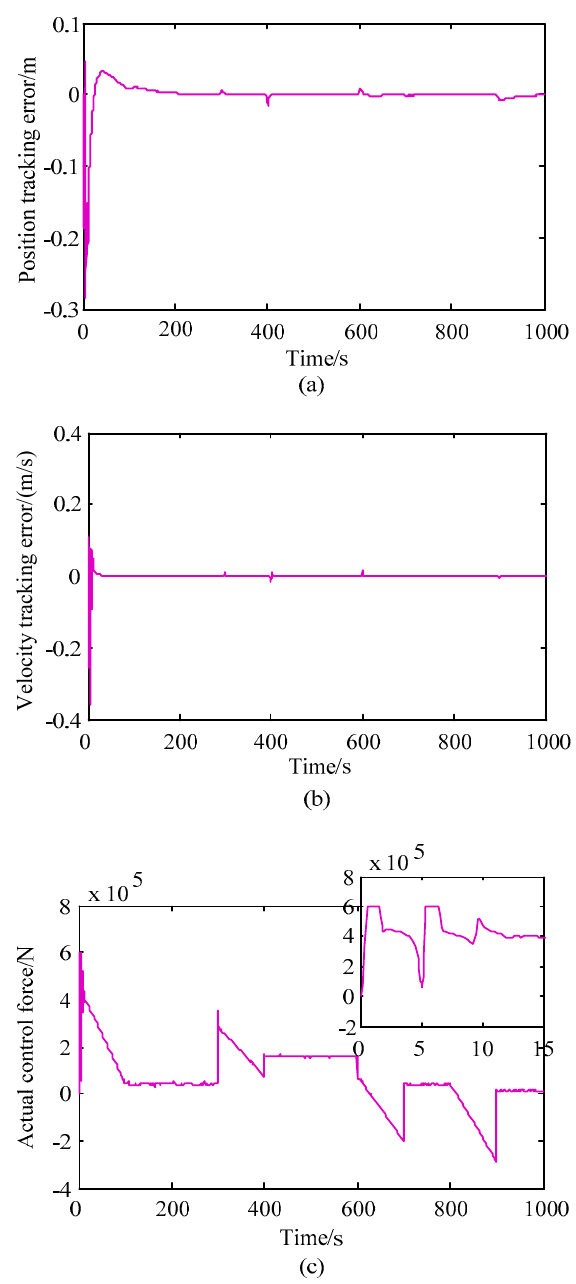
Figure 5. Control performance for high-speed trains (HSTs) without actuator faults: ( a ) position tracking error, ( b ) velocity tracking error, ( c ) actual control force.